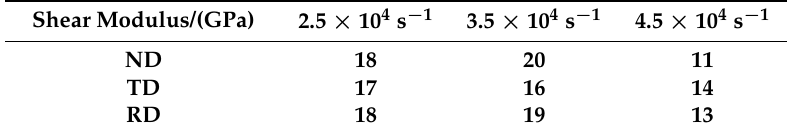
Table 4. The shear modulus of aluminum alloy 7050-T7451 at different